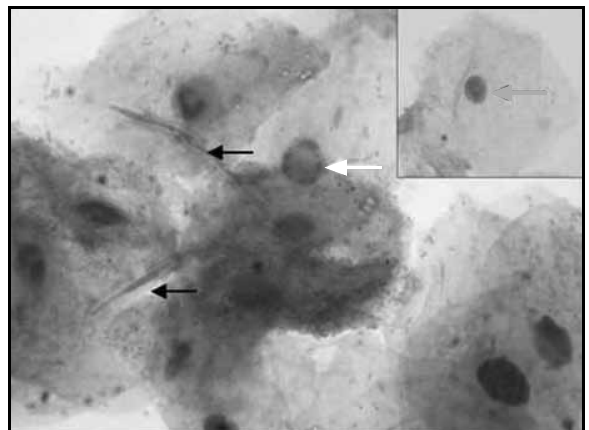
Figura 1 – Paciente 7: esfregaço de borda lateral de língua, exibindo placas de células ceratinizadas, com hifas de cândida sp. (setas pretas à esquerda),